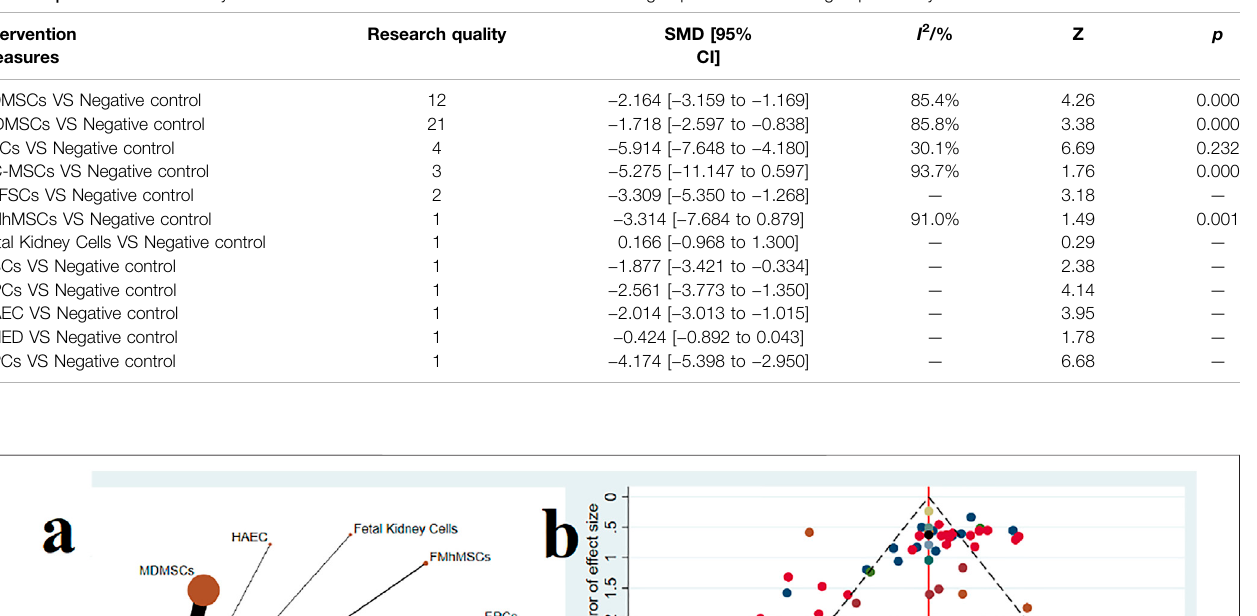
( Figure 3A ); There was no signi fi cant difference in the level of serum creatinine among different of stem cells, as detailed in Table 2 ; The comparison-correction funnel plot was asymmetric, suggesting that publication bias and small sample effect might exist ( Figure 3B ). The ranking results showed that Fetal Kidney Cells might be one of the most